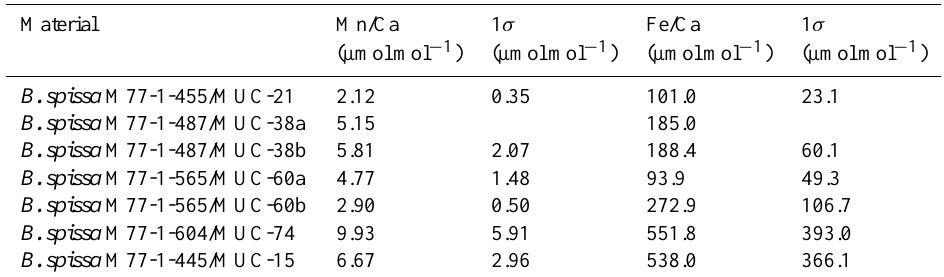
Table 4. Mean element/Ca ratios in tests of single B. spissa specimens determined with SIMS. 1 σ is representing the intra test variability inside the single